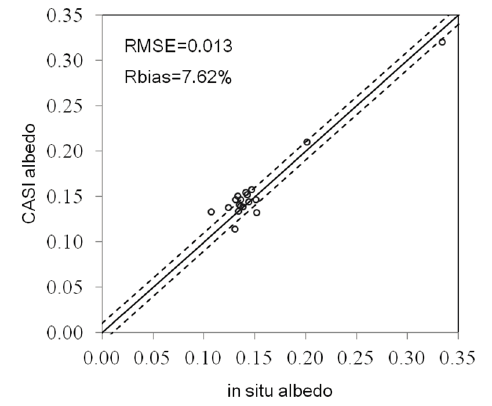
Figure 15. Comparisons between the CASI albedo and in situ albedo. The dashed lines show the bias on the interval [ − 0.01, 0.01].